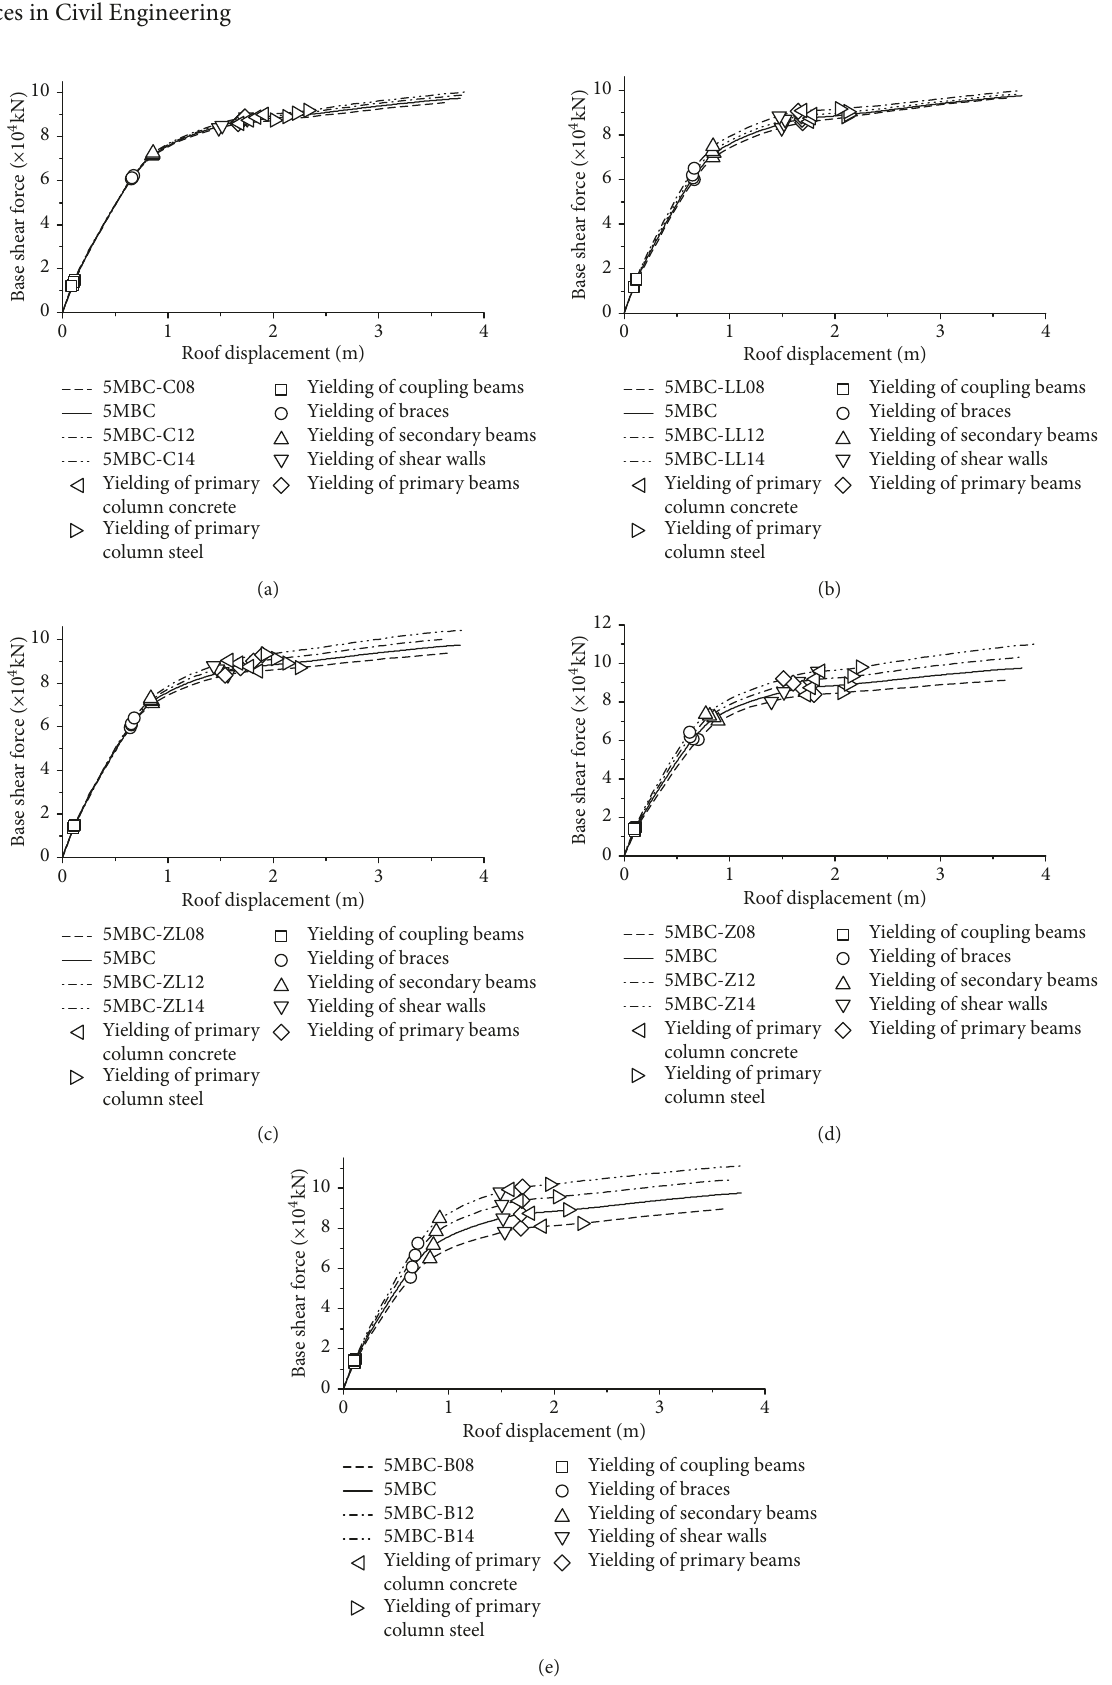
Figure 7: Influence of key parameters on structural plasticity development process in model 5MBC: (a) thickness of shear walls, (b) height of coupling beams, (c) height of primary beams, (d) sectional area of primary columns, (e) sectional area of